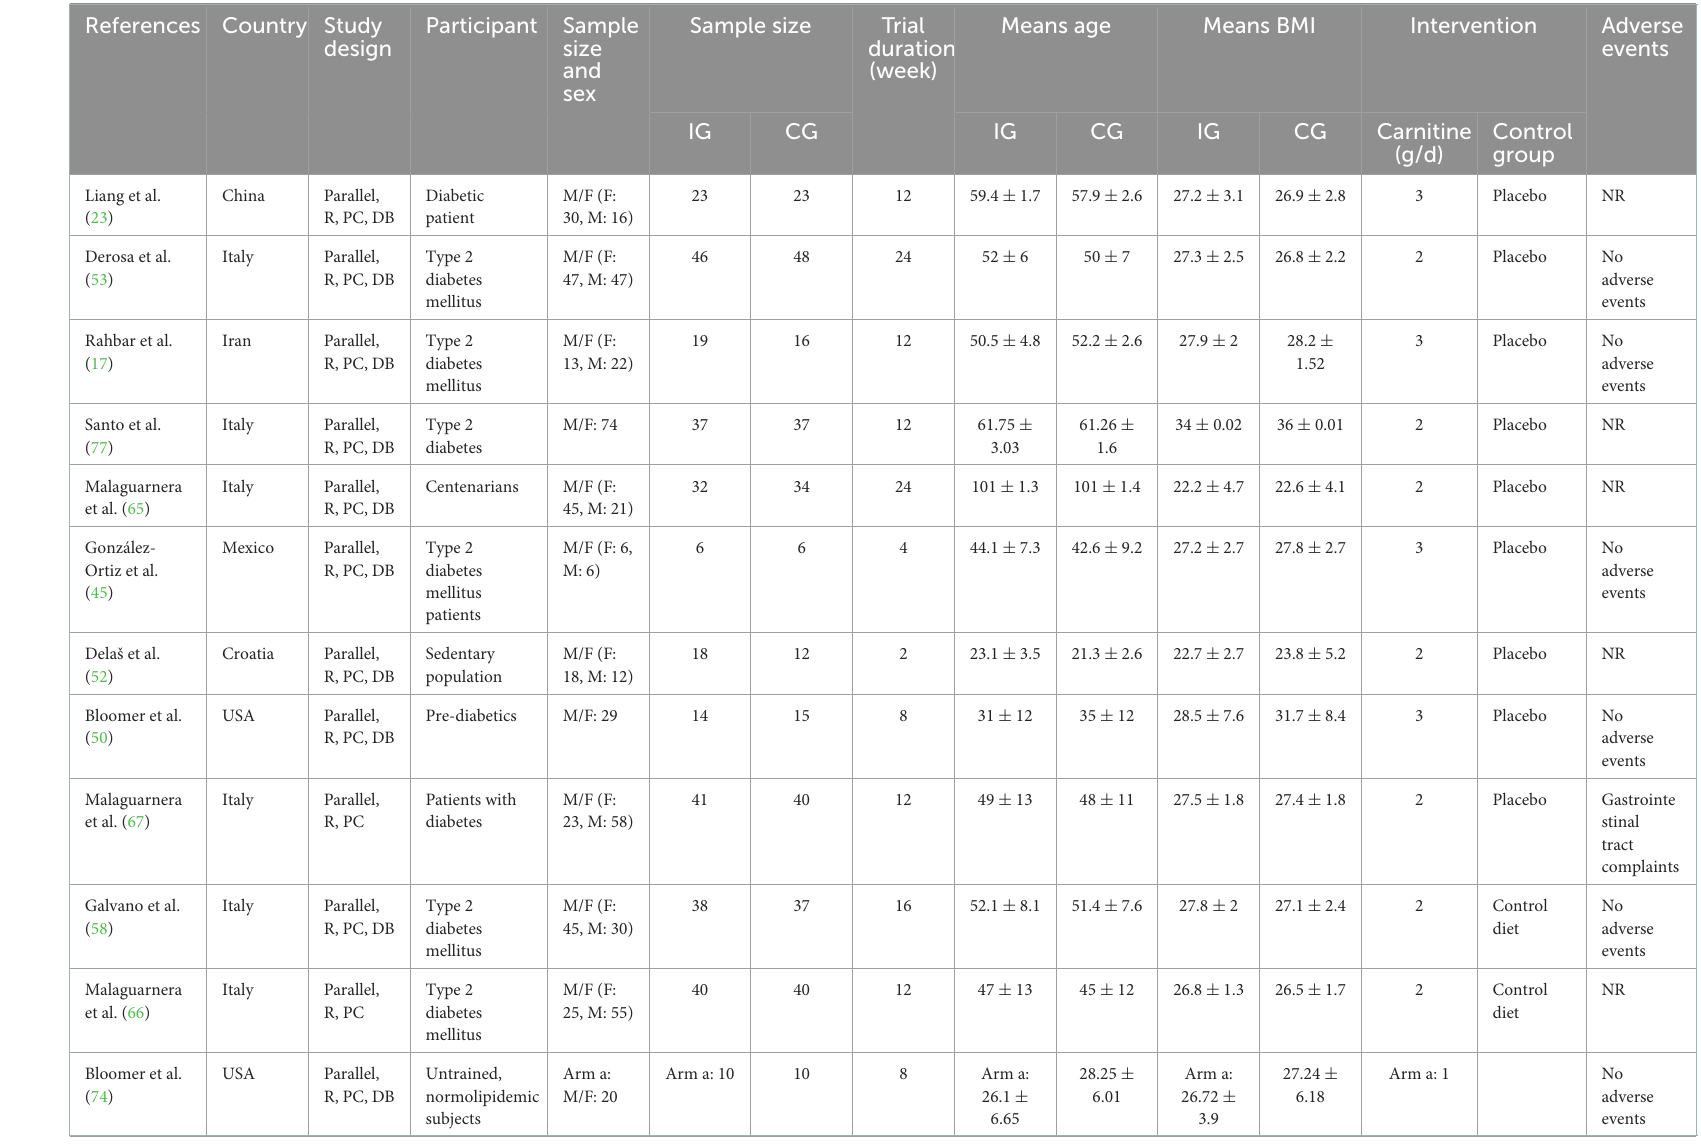
TABLE 1 Characteristic of included studies in the